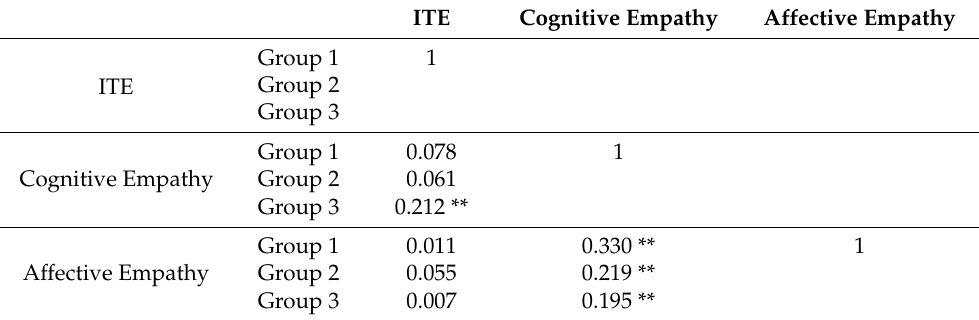
Table A1. Intercorrelation between Cognitive Empathy and Affective Empathy (Spearman’s rank correlation coefficient